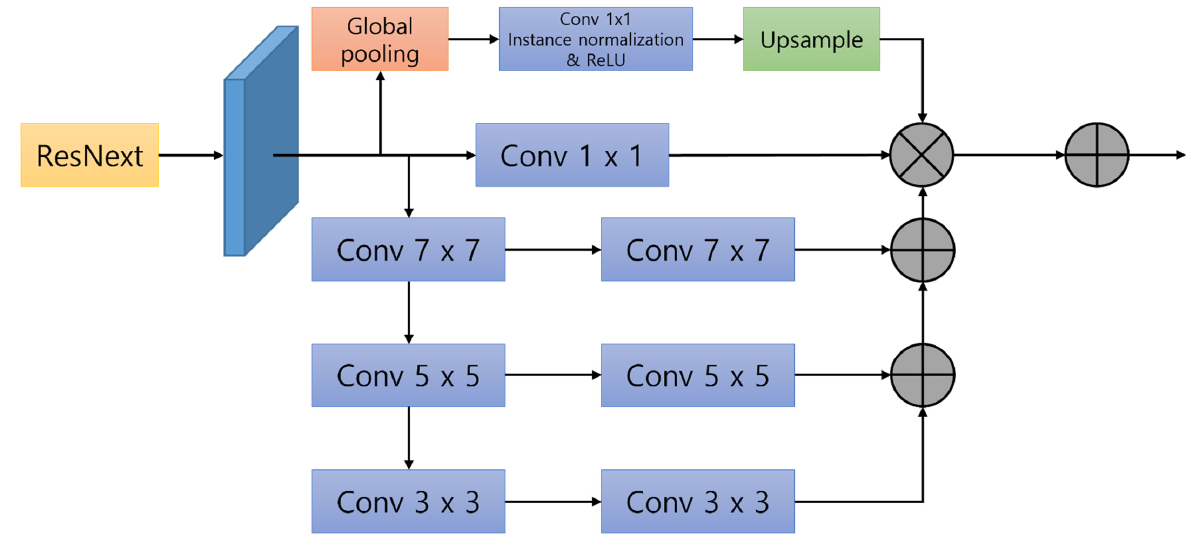
Figure 4. Structure of FPA.